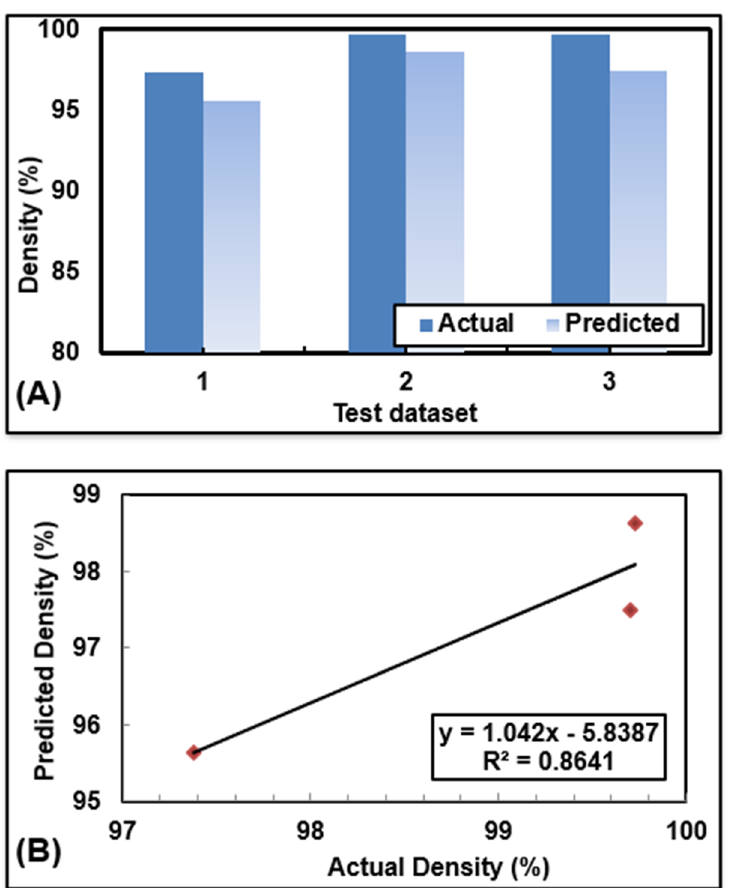
Figure 12. Linear regression: ( A ) comparison of the actual and predicted density of AM SS316L and ( B ) statistical correlation between actual and predicted values for the applied model.